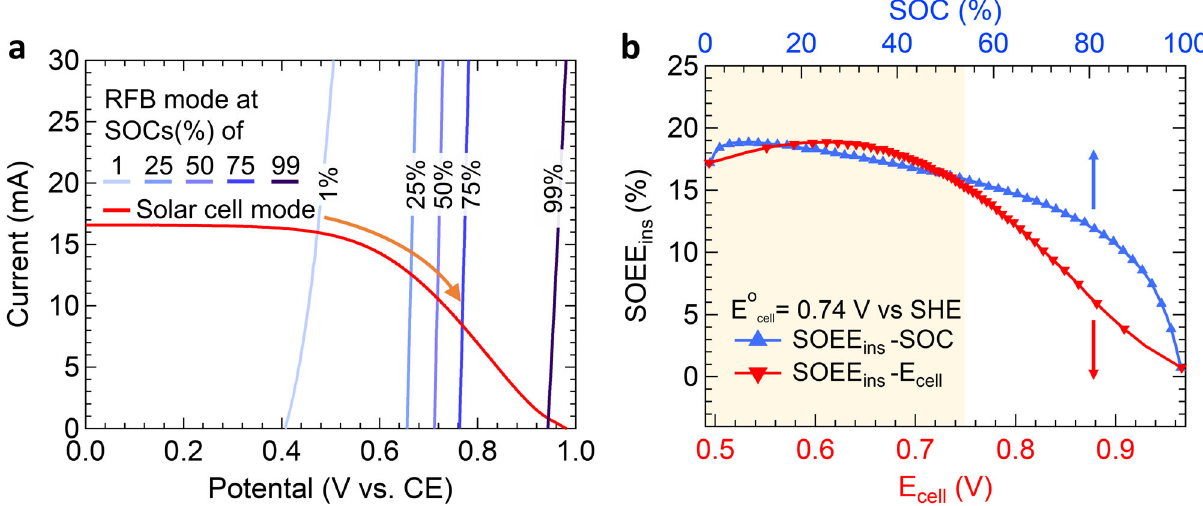
Fig. 3 Estimation of SOEE ins for SFB built with SJ-GaAs photoanode and BTMAP redox couples. a I – V performance of the GaAs photoanode at 50% SOC under solar cell mode (red line) and RFB mode (blue lines) in 0.2 M BTMAP electrolytes with the fl ow rate of 60 mL min − 1 measured under one Sun illumination. The blue lines from light to dark represent the E cell at 1 – 99% SOC of the RFB. Note that photocurrent instead of photocurrent density is plotted here. b Potential match pro fi le of the SFB ’ s SOEE ins as a function of E cell, (red curve) and the state of charge (SOC, blue